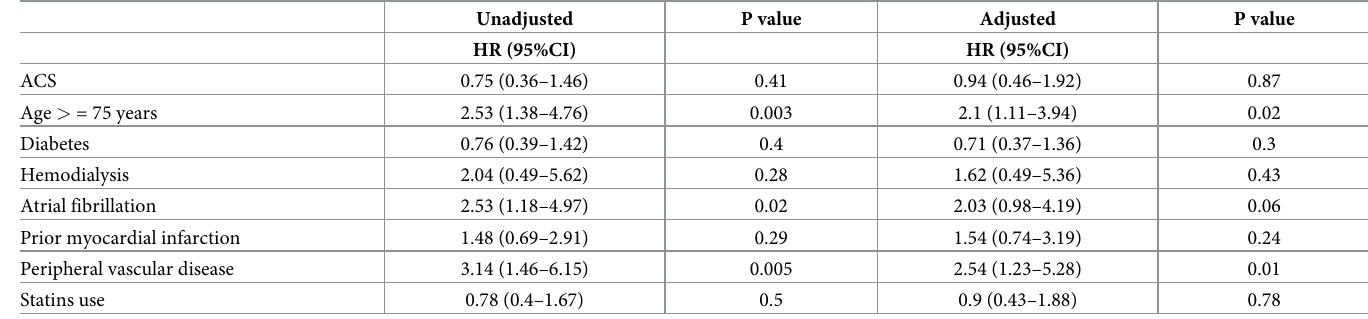
Table 3. Unadjusted and adjusted risks of the ACS versus non-ACS and the effects of the risk-adjusting variables for the primary